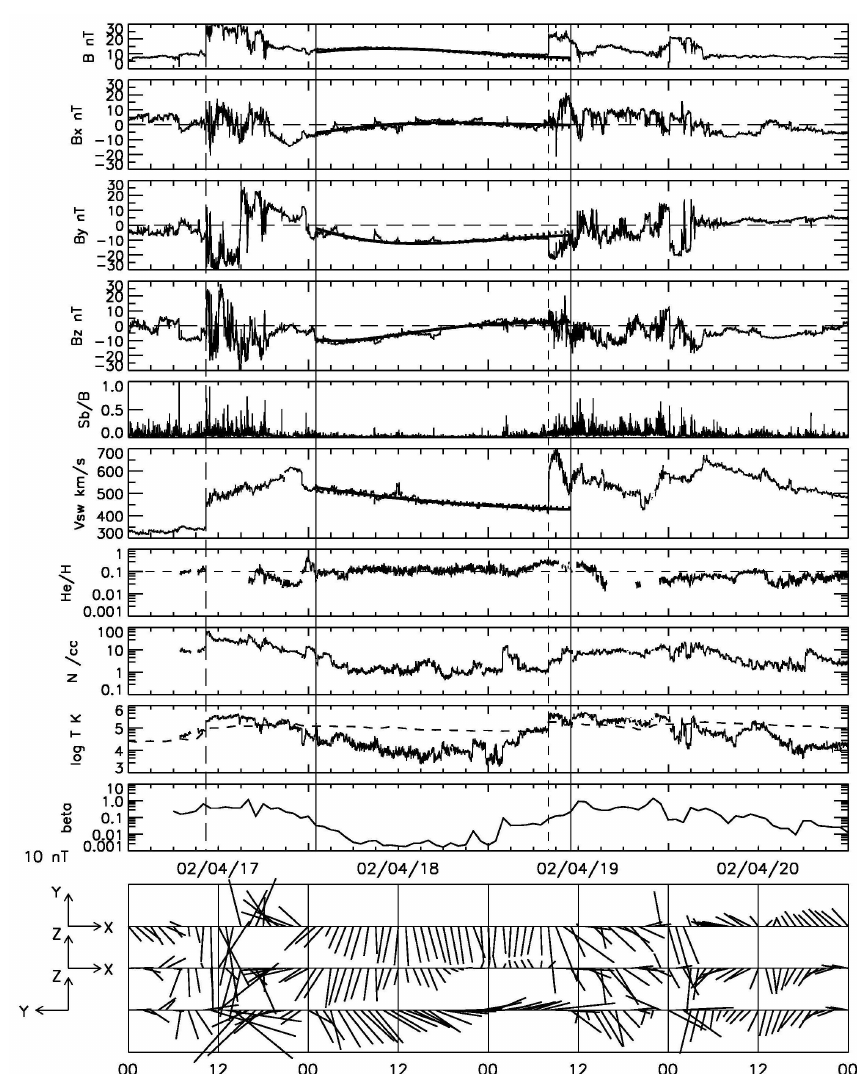
Fig. 8. Results of the fitting with the torus model (solid curve) and with the cylinder model (dotted curve) to the magnetic cloud (MC) encountered on 18 April 2002 (Event No. 15) in the same format as Fig. 4. Two shocks are indicated by two vertical dashed lines. Note that the fitting results with two models are very close to each other. The bottom three panels show the projected magnetic field vectors.